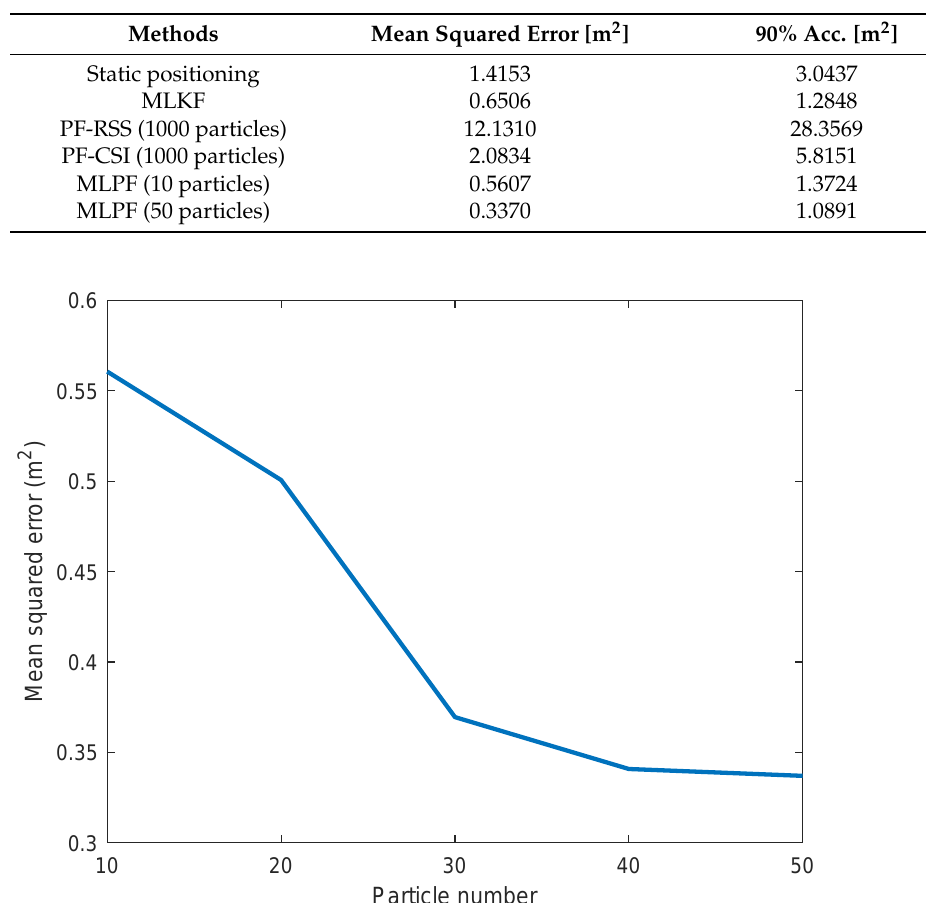
Figure 3. Impact of particle numbers on positioning